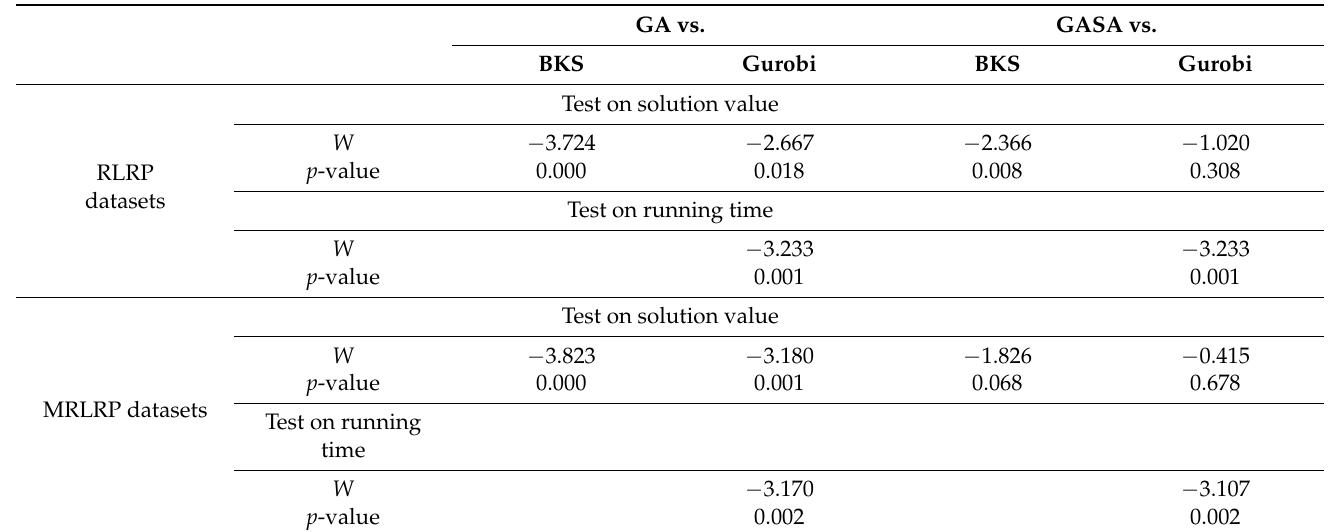
Table A4. The results of the Wilcoxon signed-rank test on the solution value and running time for RLRP and MRLRP datasets.